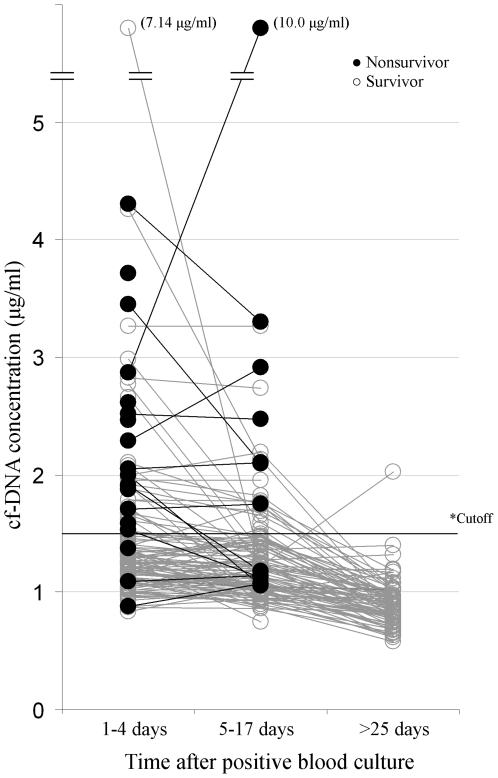
cf-DNA line plot diagram.A Line plot diagram showing cell free DNA (cf-DNA) concentration detected on days 1–4, 5 to 17 days and >25 days after blood culture in nonsurvivors (black plots) and in survivors (open plots).